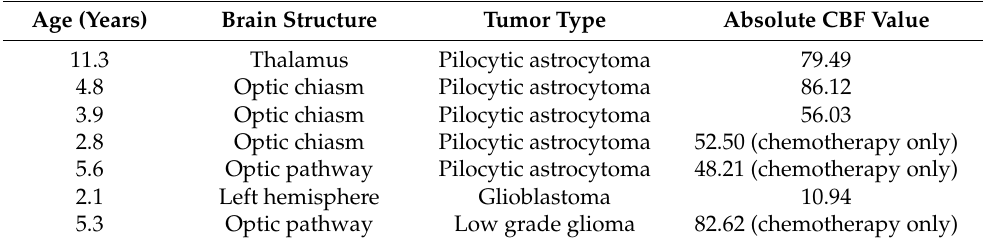
Table 8. Absolute CBF values (mL/100 g/min) [18]. Imaging Technique: Pseudo-Continuous ASL Sequence on a Philips Achieva 3T TX System